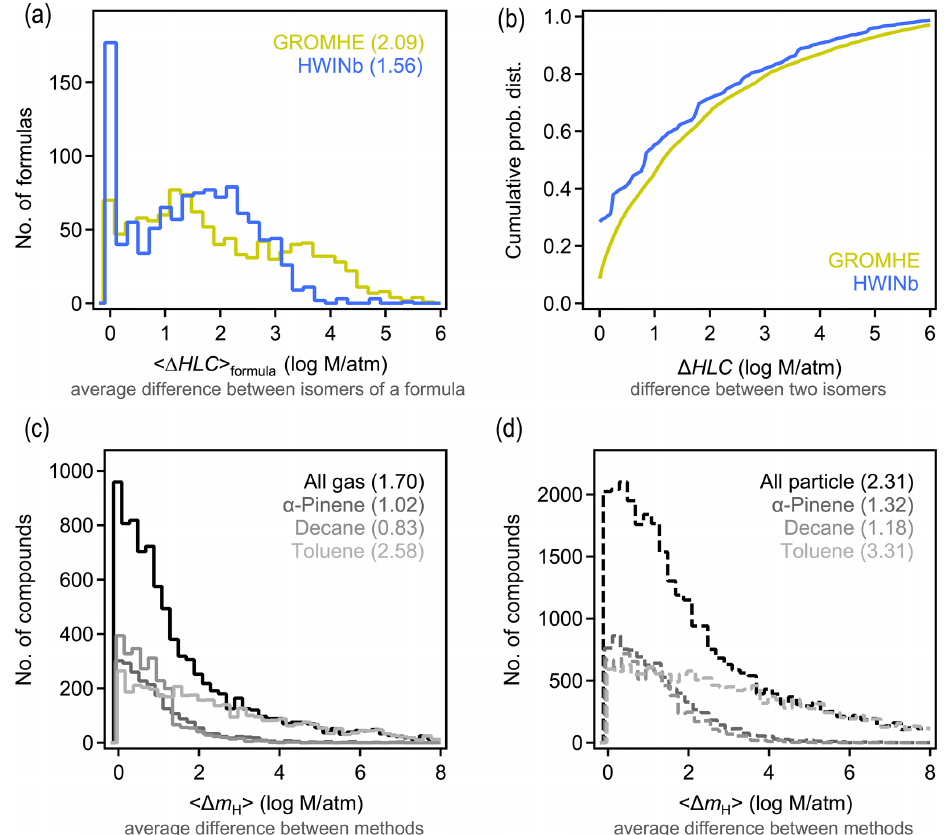
Figure 4. Differences in Henry’s law constant (HLC) between isomers and methods. (a) Distribution of (cid:104) (cid:49) HLC (cid:105) formula , which is the average difference between HLC of isomers of a given formula for the two structure-based estimation methods examined. (b) Cumulative probability distribution of (cid:49) HLC, which is the difference between any two isomers of a given formula for the two methods examined. (c–d) Distribution of absolute differences between structure-based estimates of HLC for a given compound in the (c) gas and (d) particle phase, with each oxidation system shown in a different shade. Average values of each distribution are provided in